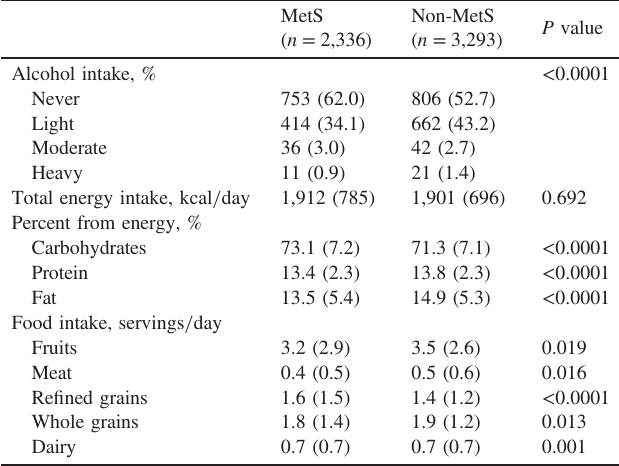
BMI, body mass index; MET, metabolic equivalent of task; MetS, metabolic syndrome. Values are n (%) or means (standard deviation). P values were assessed with Student ’ s t -test (continuous variables) or chi- square test (categorized